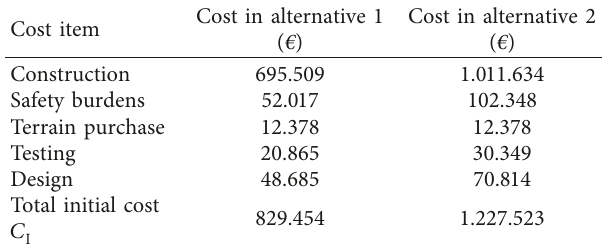
Table 2: Initial costs of the two design alternatives for the deck.